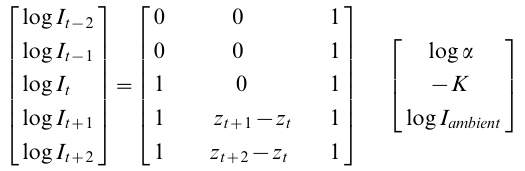
with I t and I ambient in W.cm 2 2 , K in m 2 1 and Z the depth at time t in m. (Figure 1.)